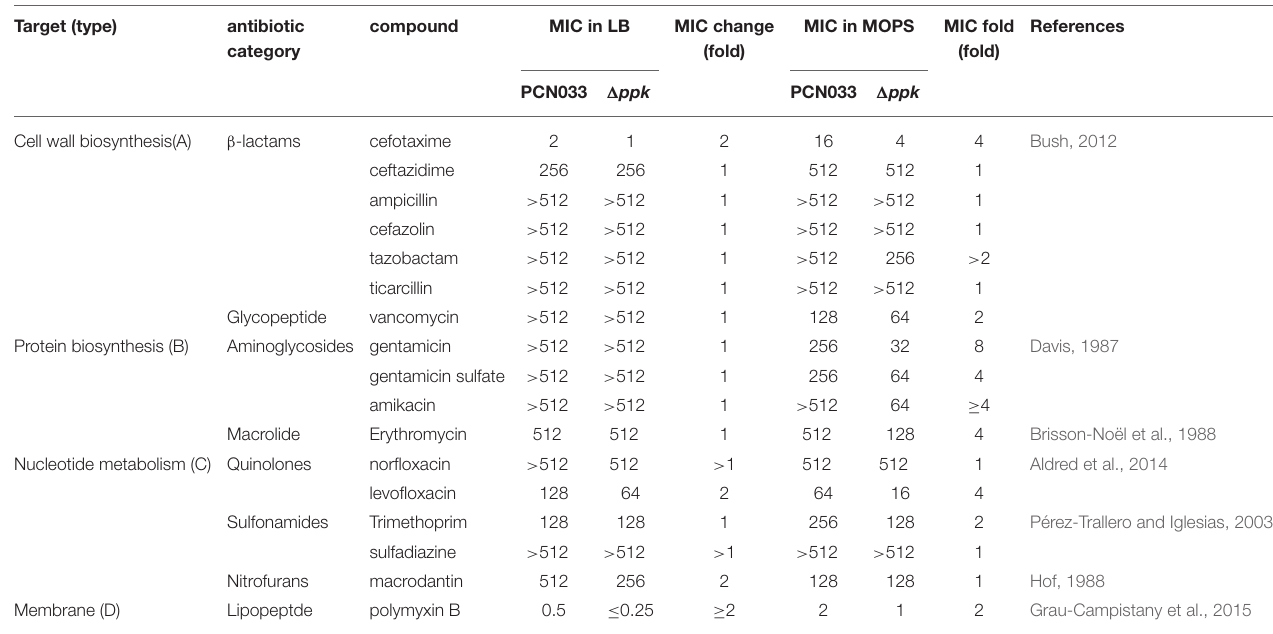
TABLE 1 | Assay of the susceptibility of planktonic cells to antibiotics (mg/L). Target